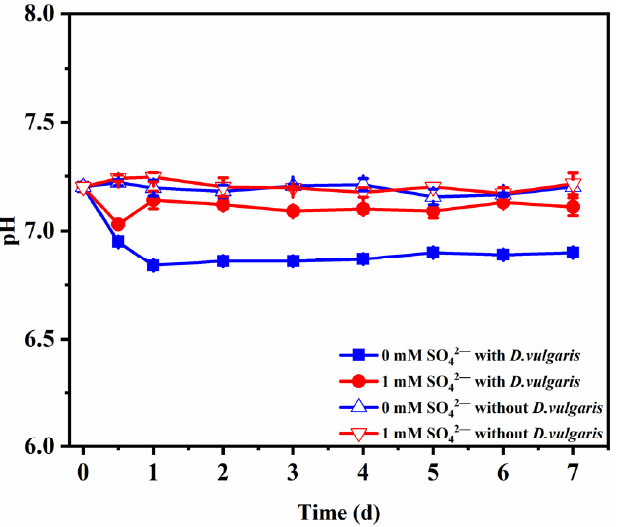
Figure 4. Variation of pH value in As(V) reduction experiment. Error bars indicate standard deviation of triplicates.